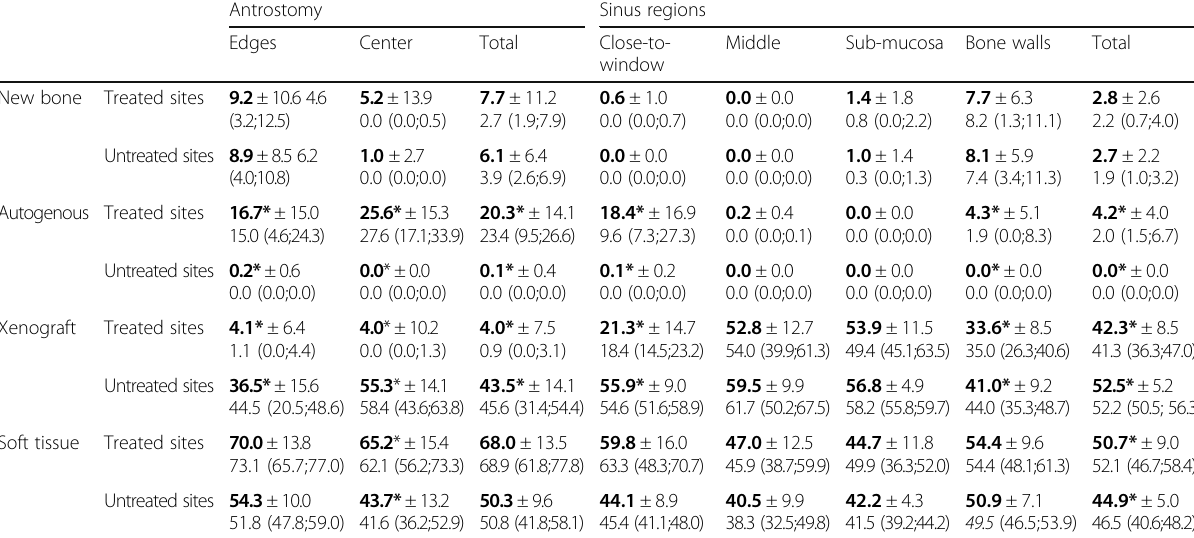
Table 1 Histomorphometric analysis. Tissues evaluated in the various regions after 1 week of healing